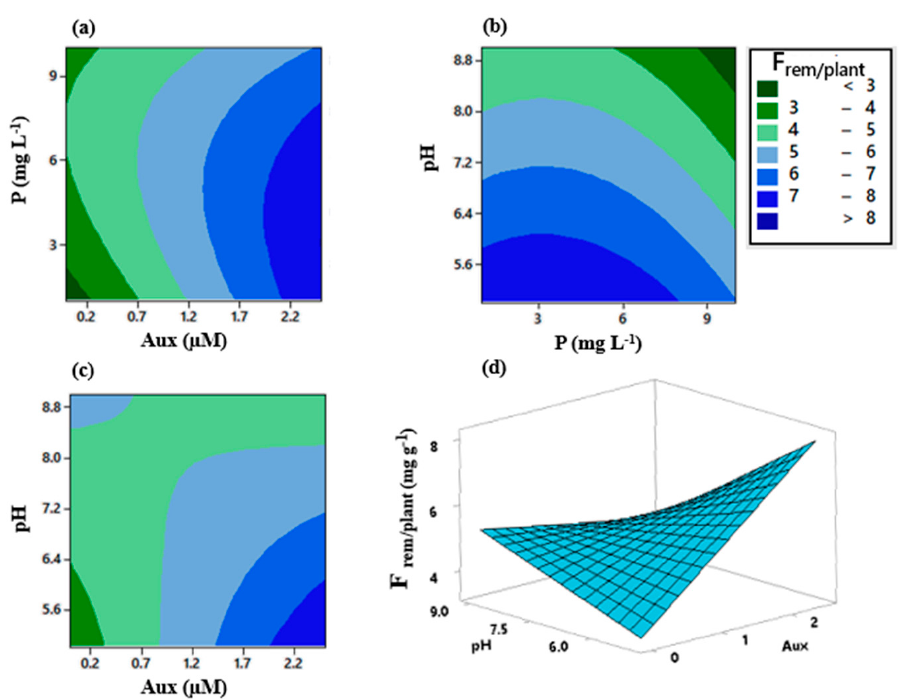
Figure 10. Contour and surface plots for fluoride removal per dry mass of plant. Each plot represents a pair of variables: ( a ) Aux x P; ( b ) P x pH; ( c ) Aux x pH; and ( d ) Aux x pH. Note: For each pair of variables represented in one graph, the other variable was held on optimum value, hence Aux = 2.5 µM, pH = 5, and P = 3.2 mg L − 1 . (cid:2) (cid:3) (cid:2) (cid:3) F − F − Table 7. Fluoride contents in plant tissues and , in mg g − 1 , dry weight), bioaccu- aerial root mulation factor (BF) (Equation (4)), and translocation factor (TF) (Equation (5)) of E. crassipes exposed to 15 mg L − 1 of fluoride for 10